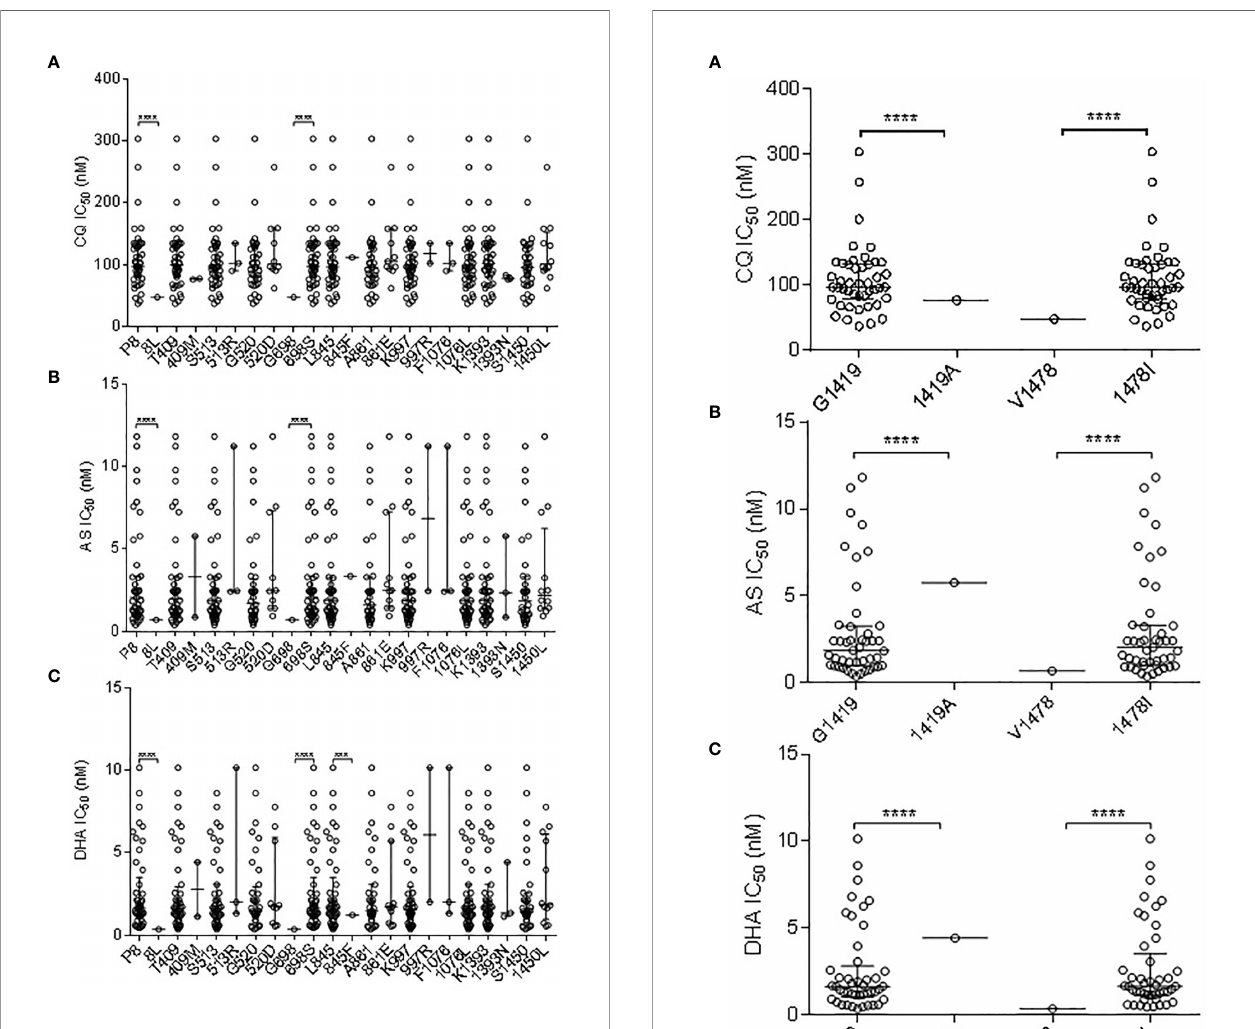
FIGURE 2 | Correlation Association of SNPs in pvmdr1 with ex vivo susceptibilities to CQ (A) , AS (B) , and DHA (C) . *** and **** represent indicate signi fi cant differences between the two alleles at P < 0.01 and <0.0001, respectively.